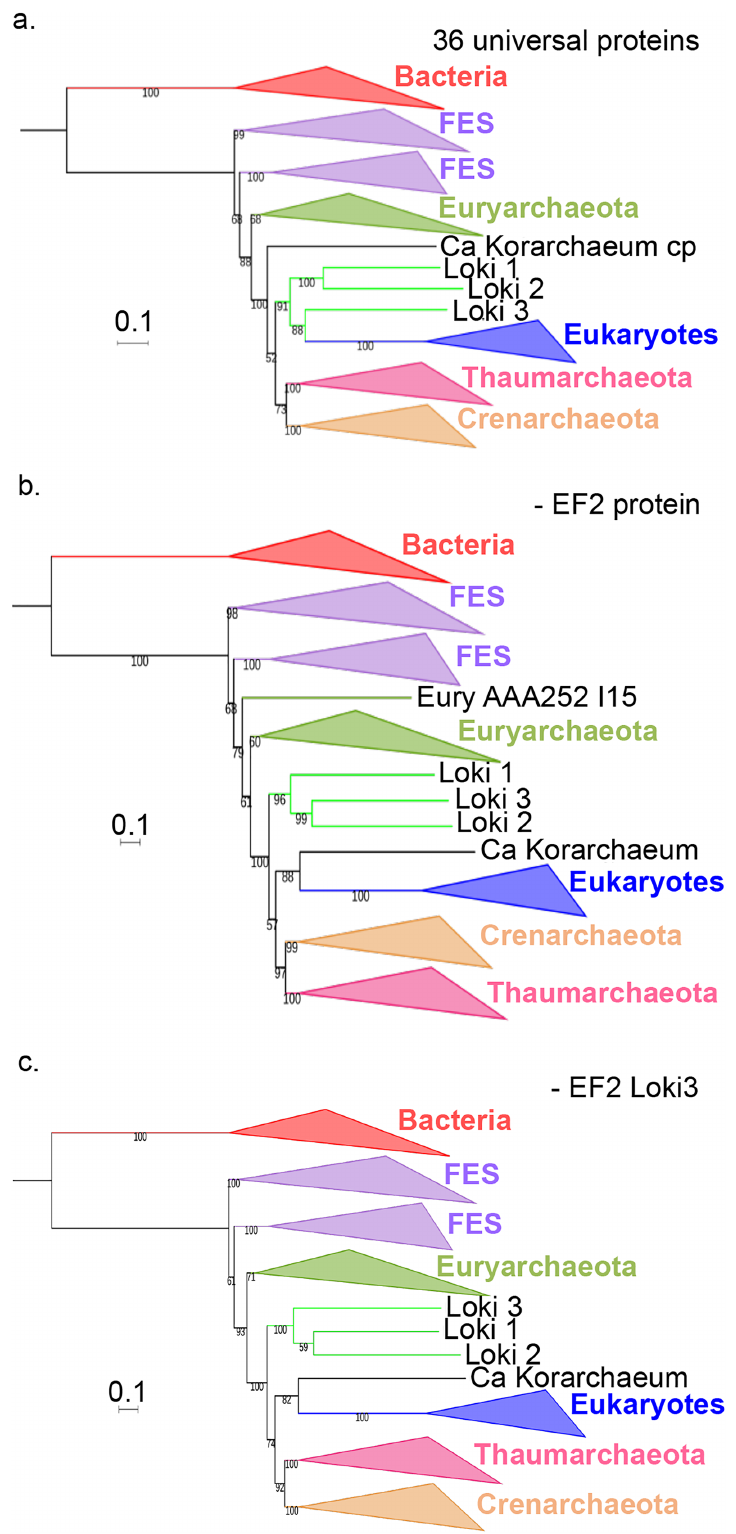
Fig 4. Impact of the EF2 protein on the original concatenated alignment. a. ML phylogenetic tree of the originalconcatenated alignment of the 36 markers (10,547 positions). b. ML phylogenetic tree of the